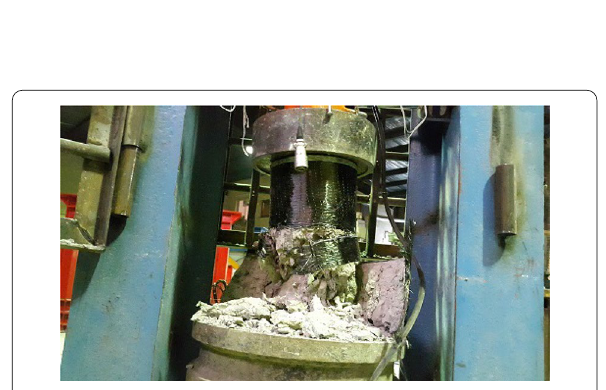
Fig. 8 Confined specimen with embedded rebar after